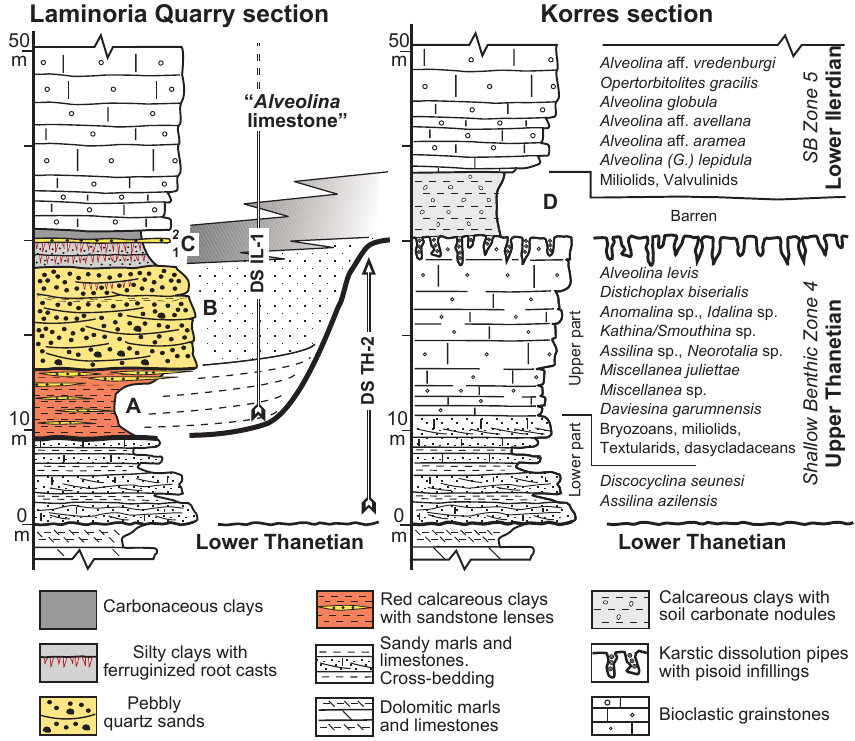
Figure 4. Columnar sections of the Laminoria quarry and Korres sections across the Paleocene–Eocene interval. DS: depositional sequences. A–D: terrestrial lithologic units described in the